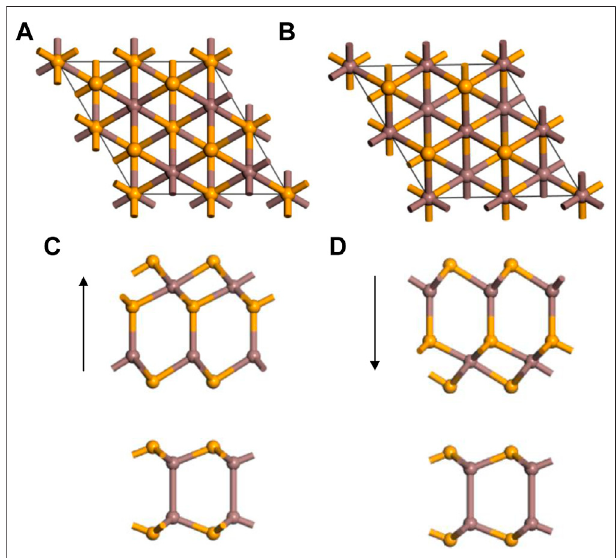
FIGURE 1 | (A) Top view and (C) side view of In 2 Se 3 /InSe heterostructures with the up polarization electric fi eld. (B) Top view and (D) side view of In 2 Se 3 /InSe heterostructures with the down polarization electric fi eld. The black arrow denotes the direction of polarization electric fi